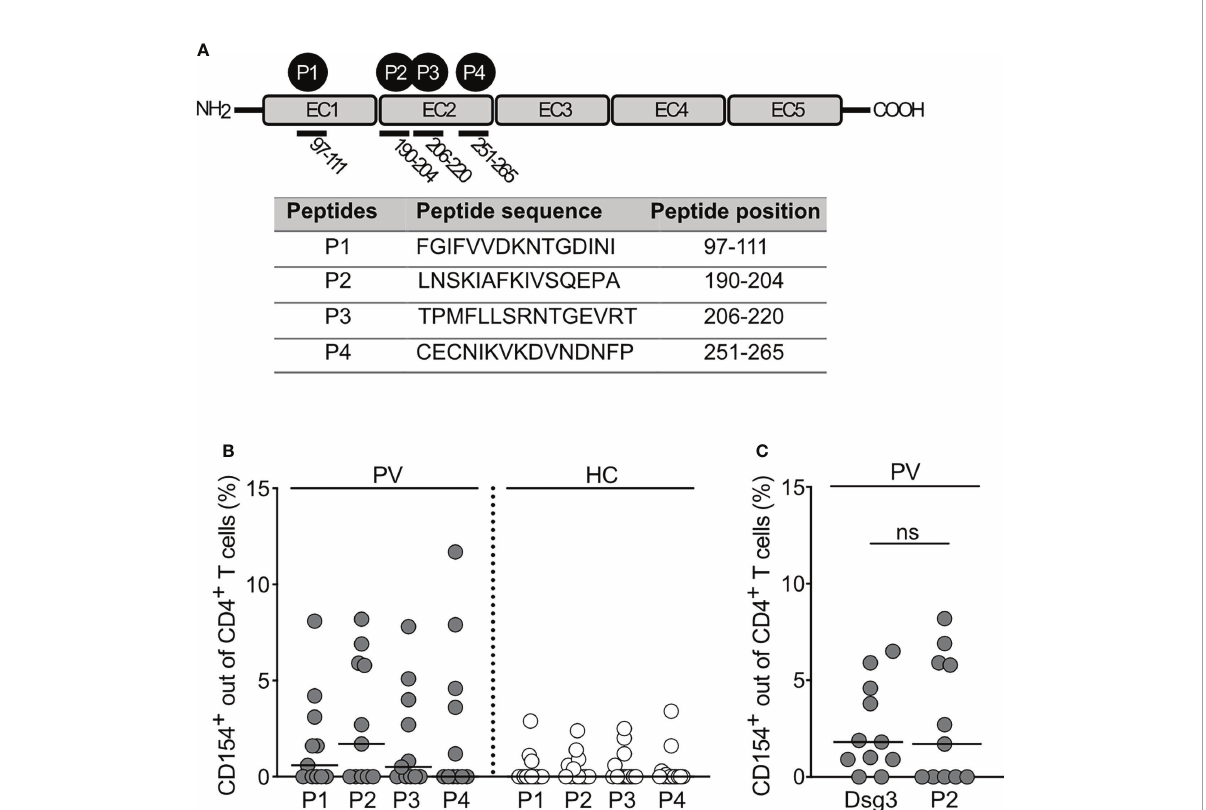
FIGURE 3 Induction of CD154 expression by Dsg3-speci fi c T cell epitopes. (A) Summary of Dsg3-speci fi c epitopes used for ex vivo stimulation. (B) Relative frequencies of CD154 expression in CD4+ T cells upon ex vivo stimulation with Dsg3-derived peptides (P1, P2, P3, P4) (PV n=11; HC n=14). (C) Relative frequency of CD154 expression out of CD4+ T cells upon ex vivo stimulation with Dsg3-derived peptide P2 and Dsg3 in PV patients (PV